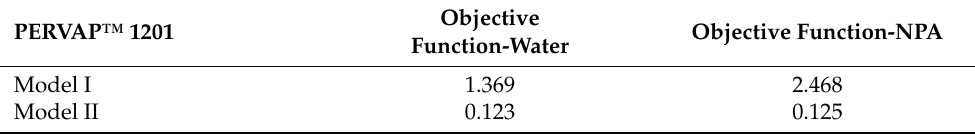
) and Model II ( Table 3. Objective functions resulted in Model I and Model Table 3. Objective functions resulted in Model I and Model II. ) in a function of feed water concentration with PERVAP™ 1201 membrane. Table 3. Objective functions resulted in Model I and Model II.